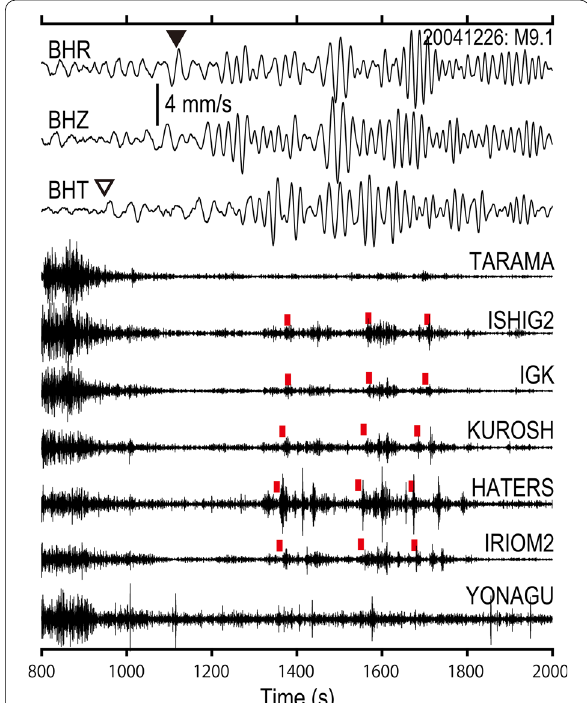
Fig. 2 Waveforms of the triggered LFEs observed in the Yaeyama area. Broadband and short-period seismographs of the 2004 Sumatra earthquake. Upper part shows the instrumentally corrected broadband seismograph at IGK. Zero time denotes the occurrence time of the earthquake. The black and white triangles denote the estimated arrival time of the Rayleigh and Love waves, respectively. The velocity of the Rayleigh and Love waves is assumed to be 4.0 km/s and 3.4 km/s, respectively. The thick vertical bar shows the scale of the broadband seismograph. Lower part shows the 2–4 Hz bandpass-filtered short-period seismograph of the N–S component. The triggered LFEs were recorded at several stations. The waveforms are plotted from western stations to eastern stations along the